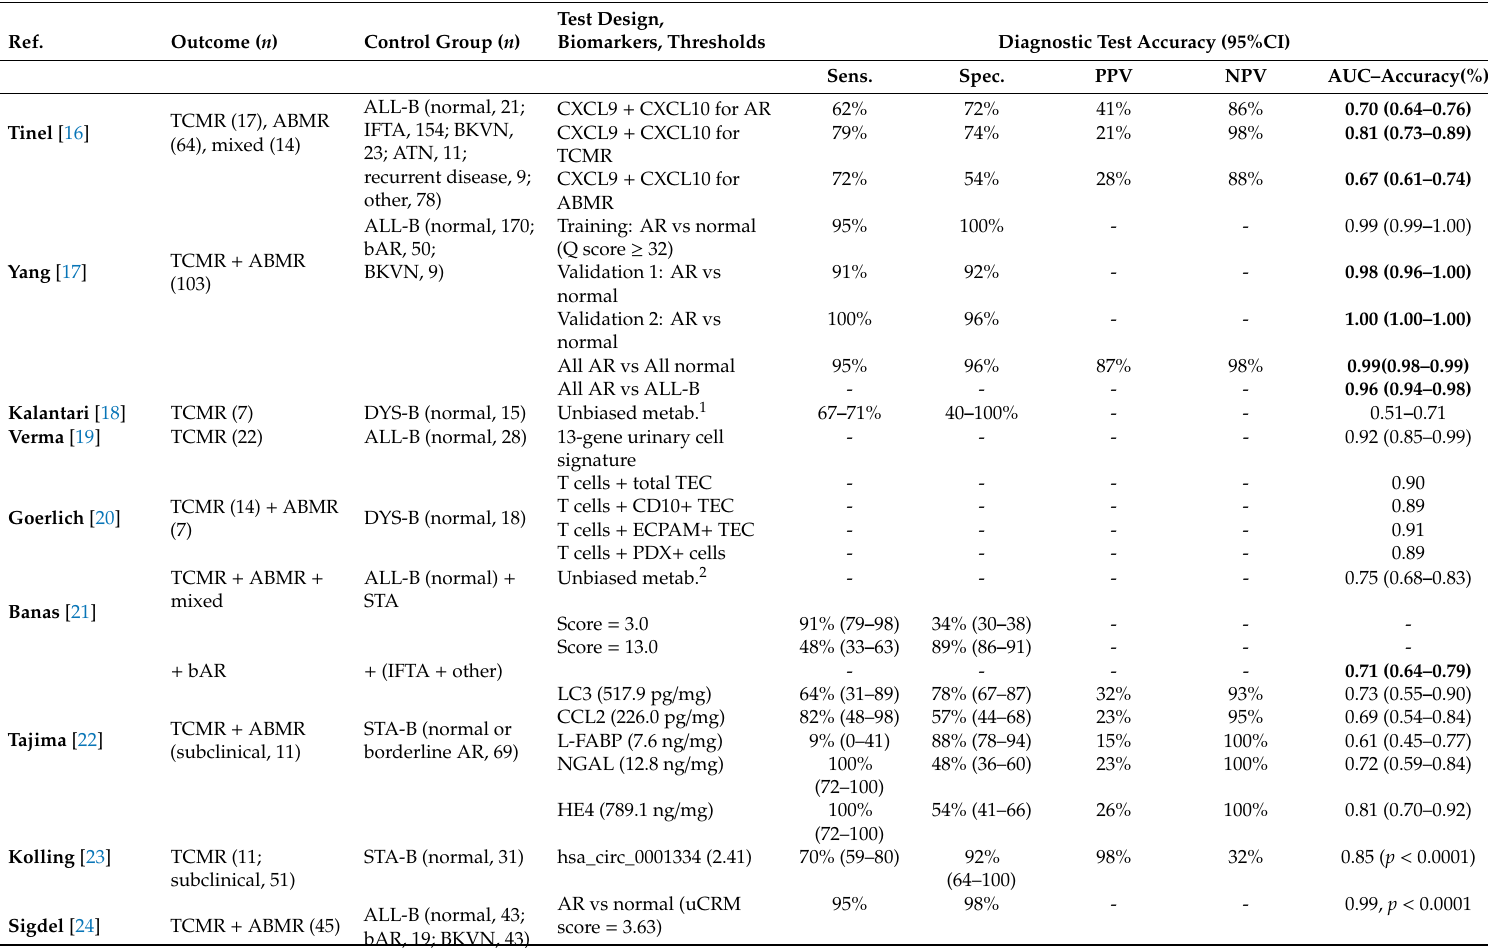
Table 4. Summary of the study results—Diagnostic studies with DTA. This table shows the outcome of diagnostic studies. Outcome and control group for the DTA analysis are reported (sample size when available), followed by test design, studied urinary biomarker(s), and thresholds when provided.